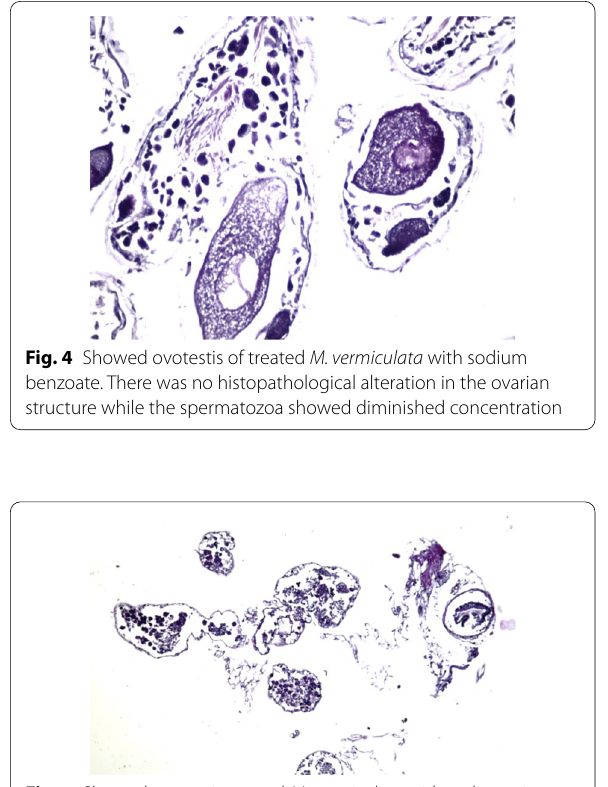
Fig. 5 Showed ovotestis treated M. vermiculata with sodium nitrate, Necrobiotic change was detected in the ova and some follicles, associated with diminished in the spermatozoal